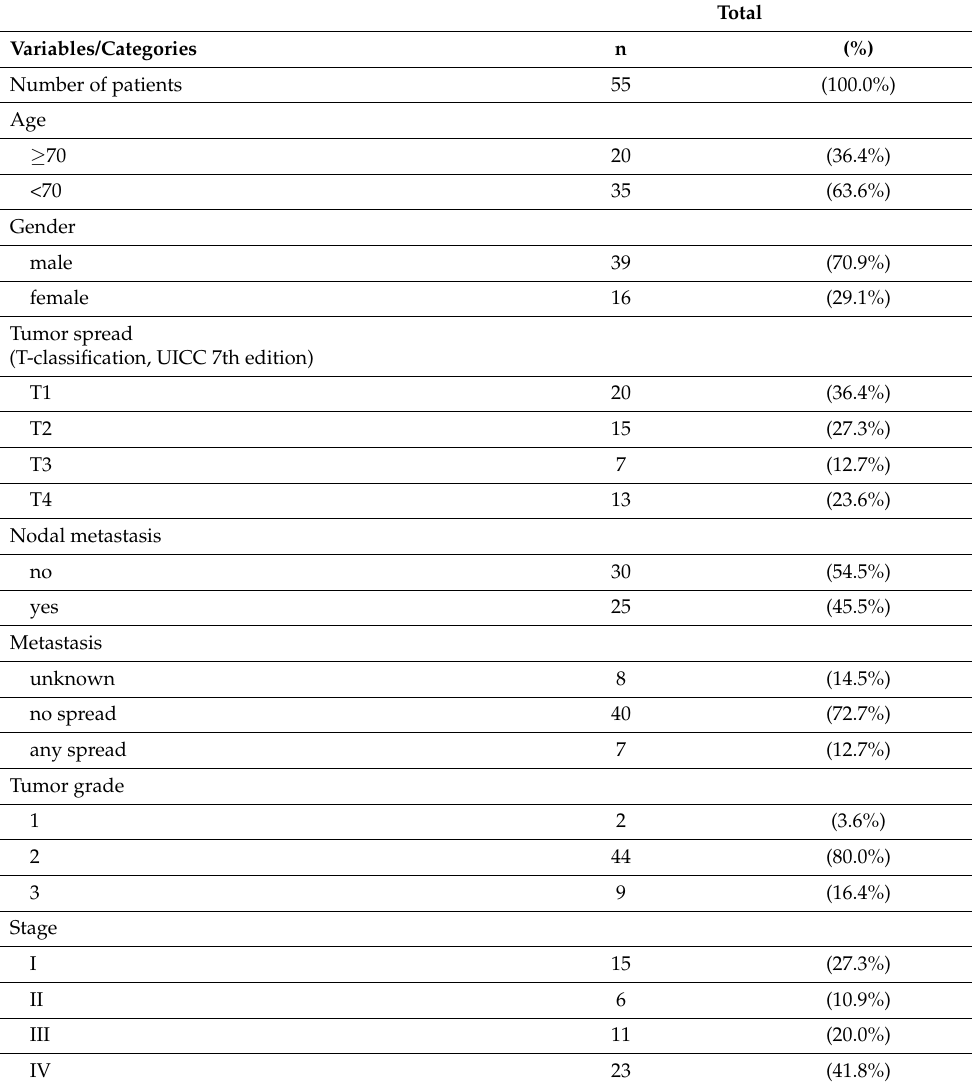
Table 1. Patient characteristics of the OSCC cohort.